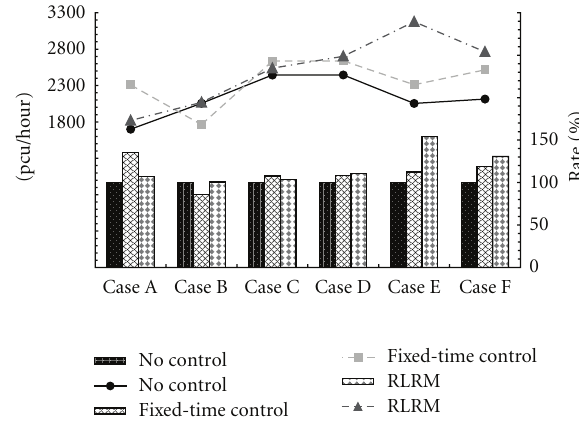
Figure 8: Outflow and its rate compared to no control.